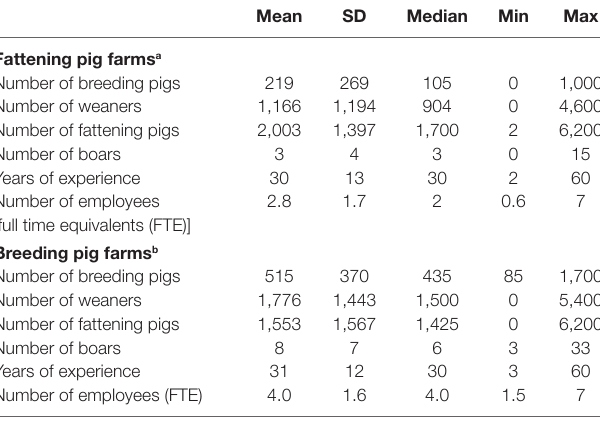
The different biosecurity scores for all pig farms (breeding farms and fattening pig farms) are presented in Table 5 . The comparison between fattening farm biosecurity scores and breeding farm bios- ecurity scores should be made with caution as breeding-fattening farms are included in both categories. The total biosecurity score ranged from 40.1 to 89.5 for the fattening farms and from 43.8 to 83.8 for the breeding farms (on the scale of 0–100). The highest mean subcategory score was for score A (purchase of animals and semen) and the lowest mean score was for score H (farrowing